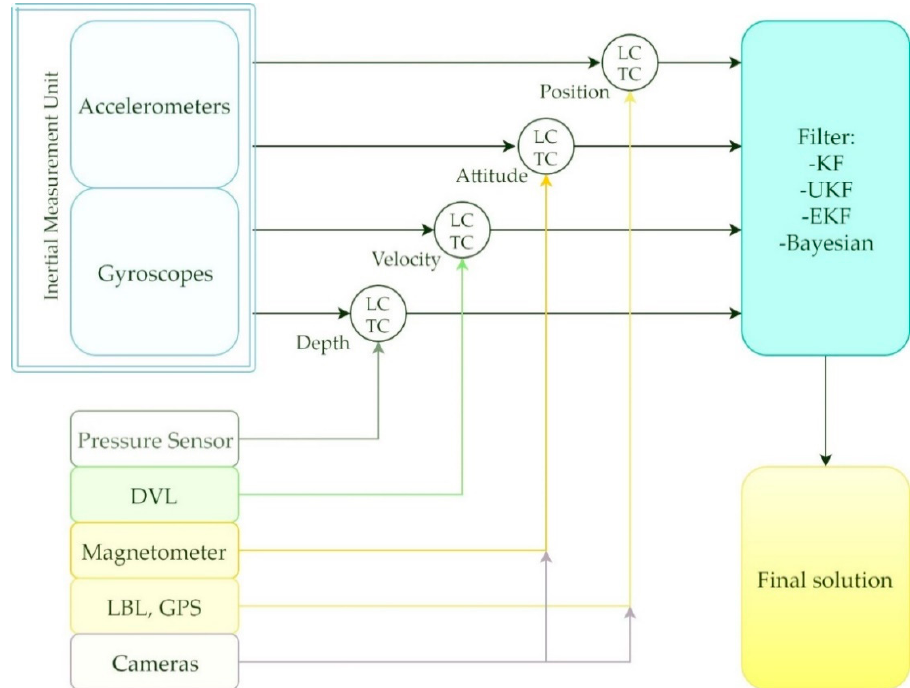
Figure 14. Sensor fusion alternatives for AUV positioning.